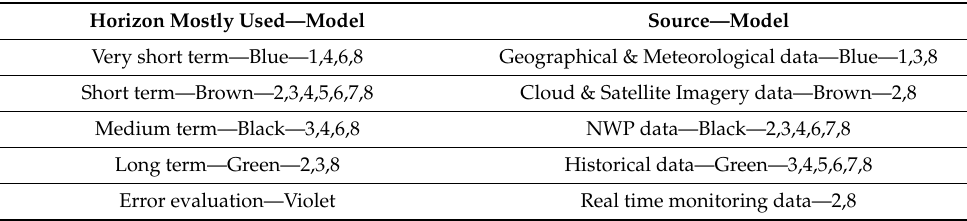
Figure 16. Pictorial conclusion of solar energy forecasting models. Table 12. Colour code representation of represented mapping’s in Figure